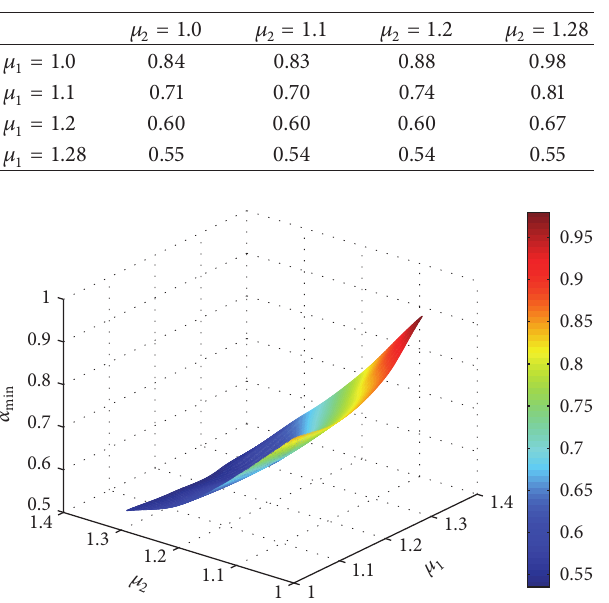
Figure 3: The simulation of correlation between pair ( 𝜇 1 , 𝜇 2 ) and 𝛼 min